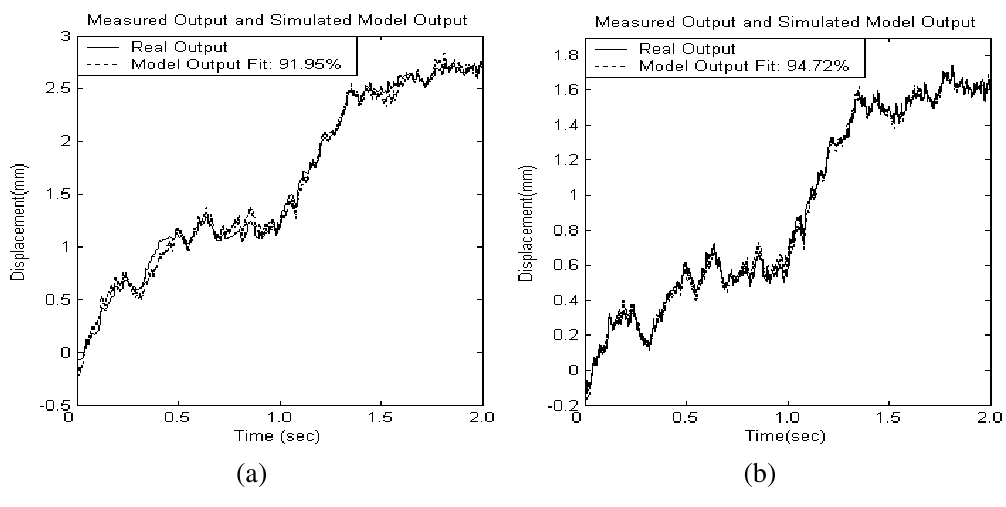
Figure 3. System identification model output. (a) X axis; (b) Y